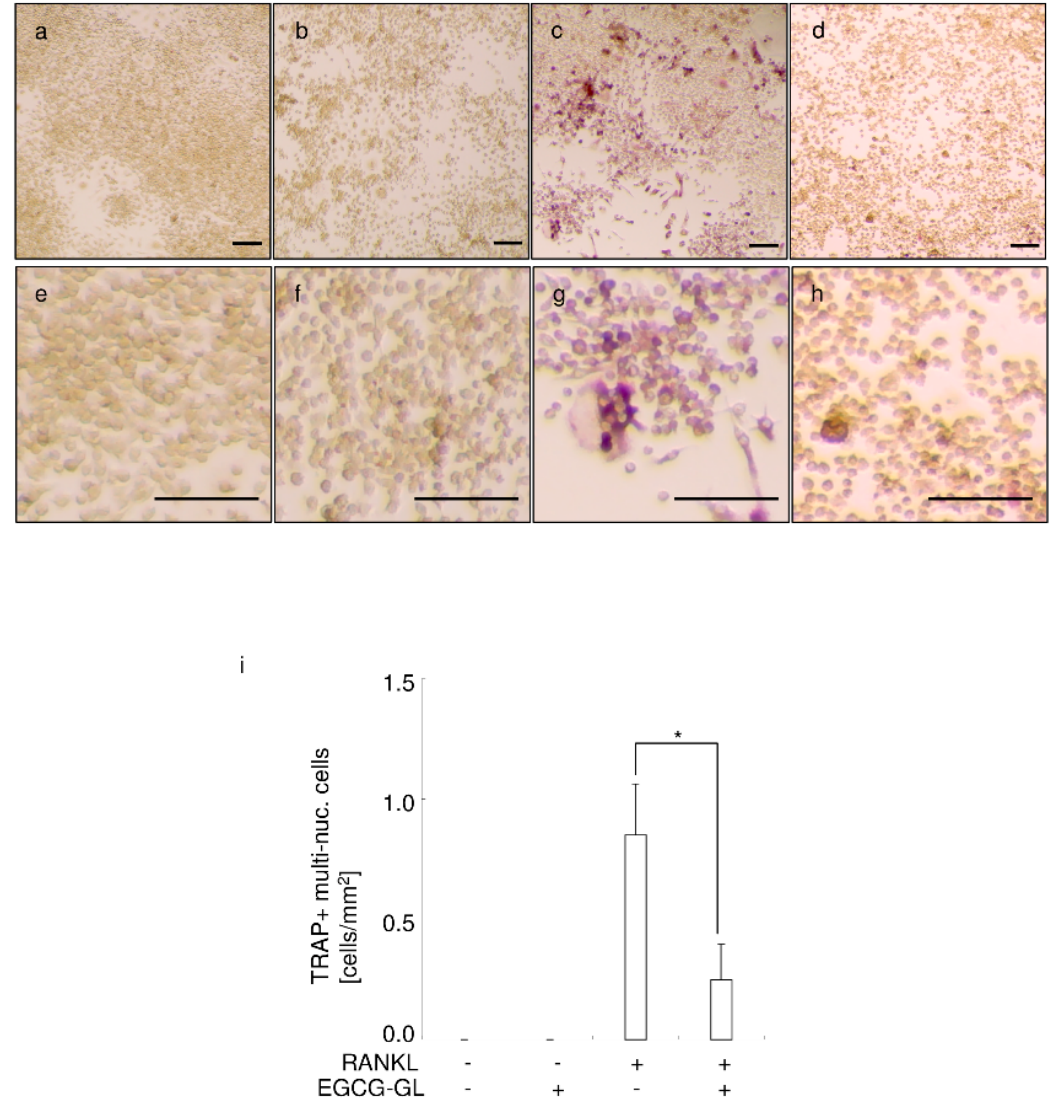
Figure 5. EGCG-GL inhibits RANKL-mediated osteoclastogenesis. Representative photographs of control ( a , e ), EGCG-GL-treated ( b , f ), RANKL-treated ( c , g ), and RANKL + EGCG-GL-treated ( d , h ) are shown. Middle magnification ( a – d ) and high magnification ( e – h ) data are shown. Scale bar: 100 µm. ( i ) Mean number of TRAP-positive multi-nucleated cells. (n = 3) *: p < 0.05 between samples. 3.6. Local Single EGCG-GL Injection Inhibited LPS-Mediated Oxidative Stress in